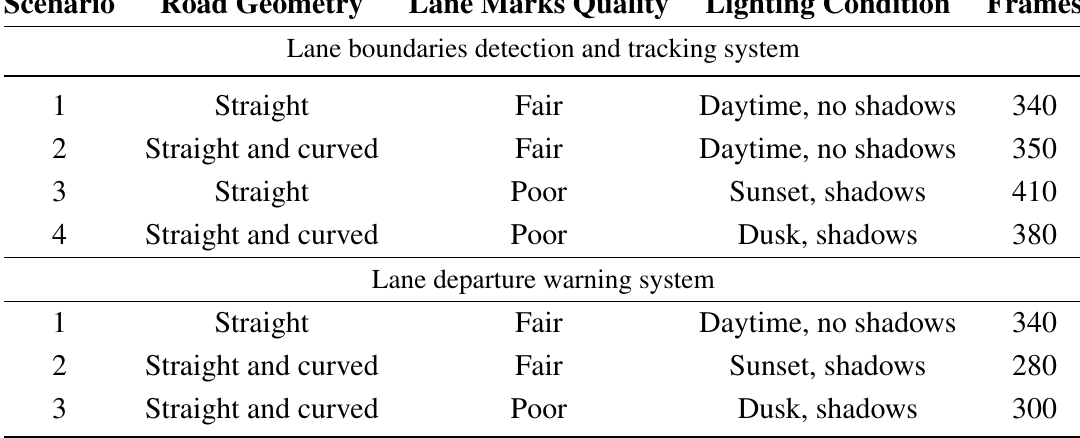
Figure 8. Examples of lane detection and tracking results for the considered